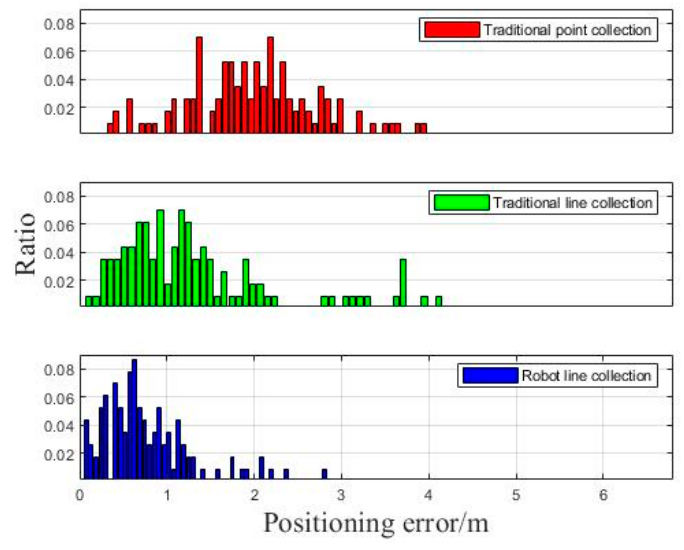
Figure 11. Positioning error distribution of static test.